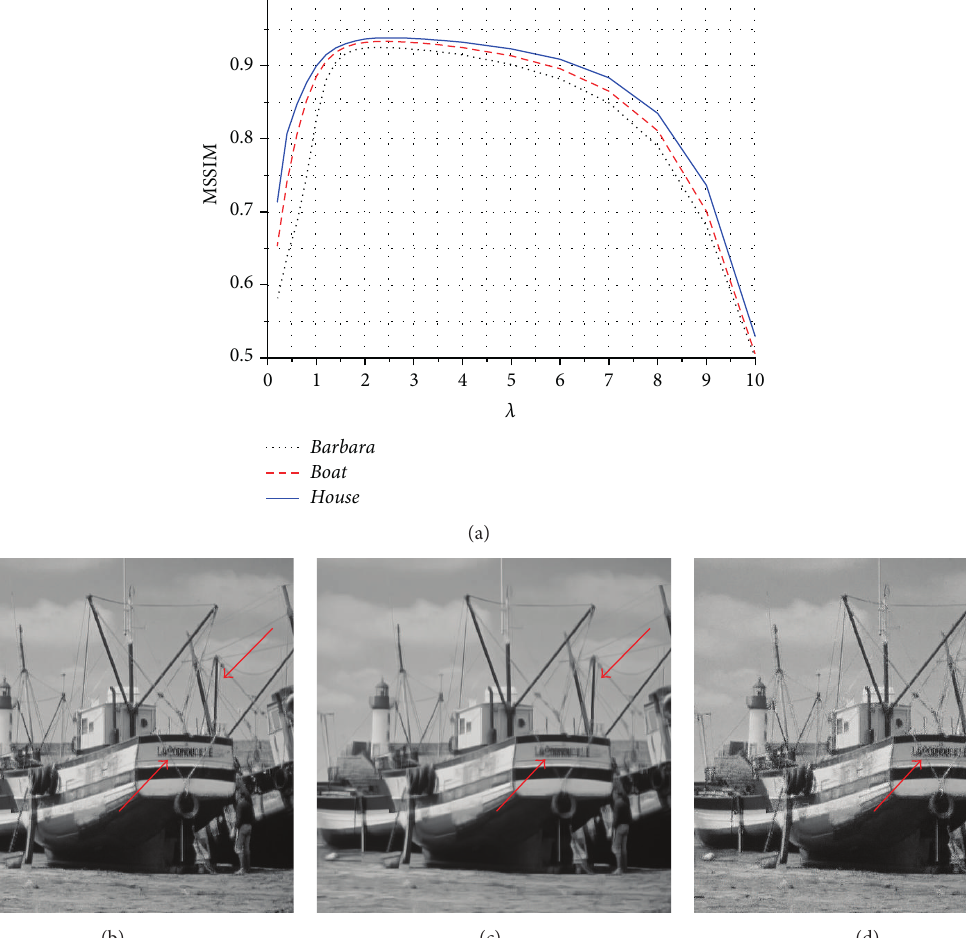
Figure 13: Effect of regularization parameter 𝜆 for the proposed approach. (a) The curve of MSSIM versus 𝜆 ; (b)–(d) reconstructed images when 𝜆 = 2, 1, 7 , respectively. Note: tests are performed at 50% impulse noise level.